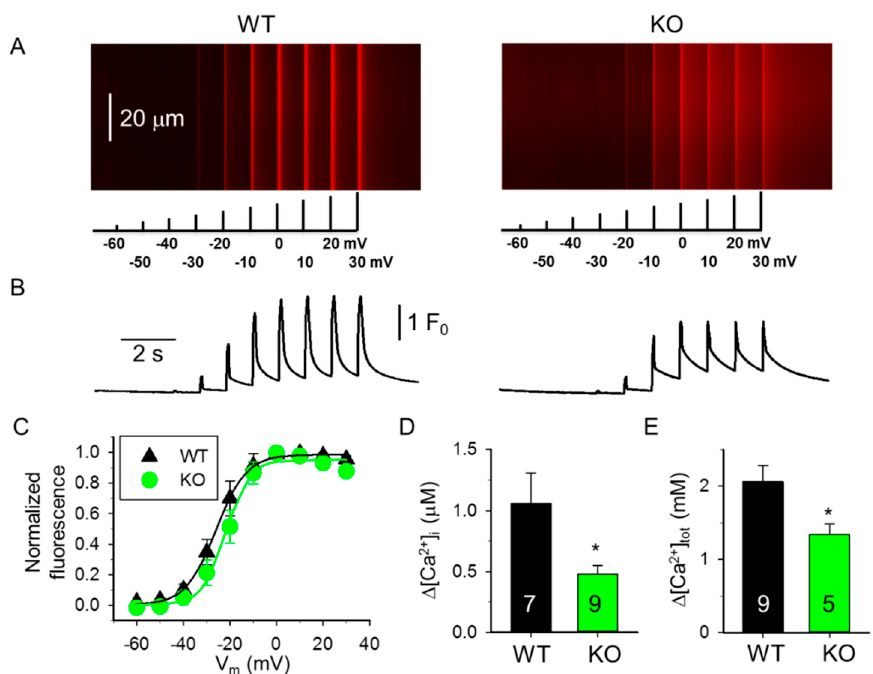
Figure 2. Membrane potential dependence of changes in [Ca 2 + ] i in fibers from 4-month-old WT and sAnk1 KO mice. ( A ) Line-scan images of changes in [Ca 2 + ] i elicited under whole-cell voltage-clamp by 100 ms long progressively increasing membrane depolarizations ranging between − 60 mV and + 30 mV, with 10 mV increments every 500 ms in WT and KO fibers. Each cell was held at − 80 mV and perfused with 10 mM EGTA. The scale bar in the left panel corresponds to both line-scans. ( B ) Temporal profile of the changes in [Ca 2 + ] i calculated from the corresponding images in panel A by averaging 50 lines in the spatial domain normalized to average resting F 0 ( x ). ( C ) Voltage dependence of the changes in [Ca 2 + ] i . Values obtained for individual fibers were first fitted by a Boltzmann function (Equation (1)) and then normalized to the obtained maximum for a given fiber, and finally averaged over the fibers. Continuous lines represent the best fit of the Boltzmann function to the average values with parameters of k = 8.95 and 6.17 mV, and V 50 = − 21.60 and − 20.91 mV, for WT ( n = 10) and KO ( n = 9), respectively. ( D , E ) Pooled data for ∆ [Ca 2 + ] i ( D ) and the total amount of Ca 2 + released ( E ) at + 30 mV depolarization from four WT and five KO mice. To assess the peak change in [Ca 2 + ] i ( D ) and the amount of Ca 2 + released ( E ), 100 ms and 1 s long single pulses were used, respectively. Numbers in columns show the number of fibers averaged. * denotes significant di ff erence from WT at p < 0.05.